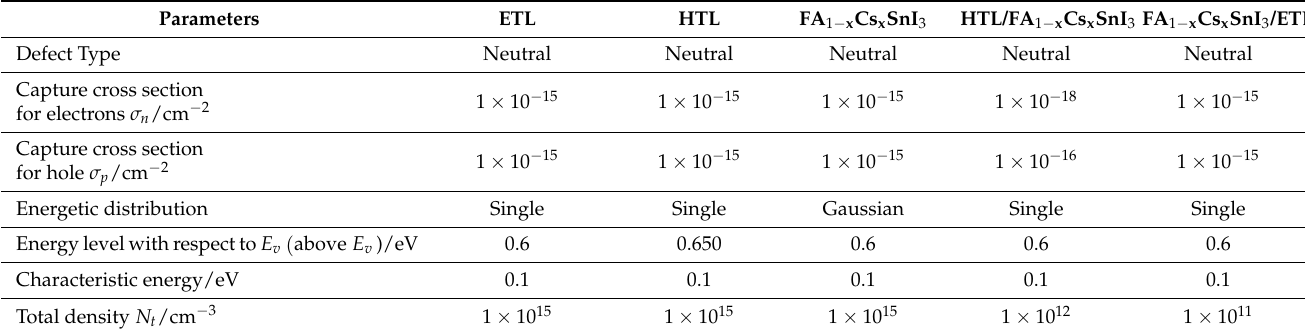
Table 3. Defect density values inside the layers and at interface of the